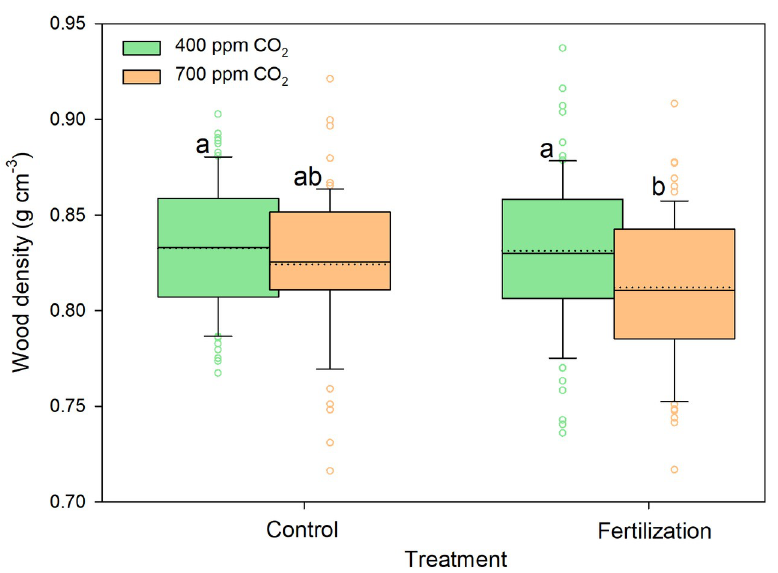
Fig 6. Changes in over-dry wood density of sessile oak saplings (n = 72) treated under ambient (400 ppm CO 2 ) and elevated (700 ppm CO 2 ) and different nutrient supplies. The data are expressed as medians (solid lines) and means (dotted lines) of measurements. The box boundaries mark the 25 th and 75 th percentiles and whiskers the 10 th and 90 th percentiles. Circles mark outliners. Different letters indicate significant differences (p � 0.05) estimated on the base of Duncan’s ANOVA post-hoc